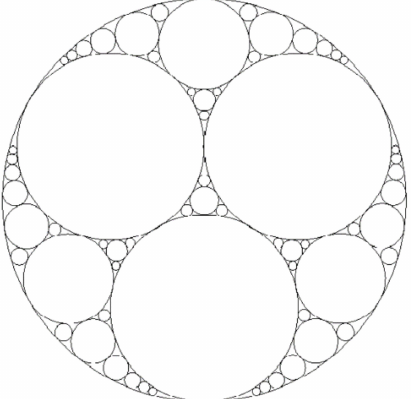
Figure 4. A fractal shape called an Apollonian gasket, where the largest possible circle is progressively placed into each area that is not contained within a